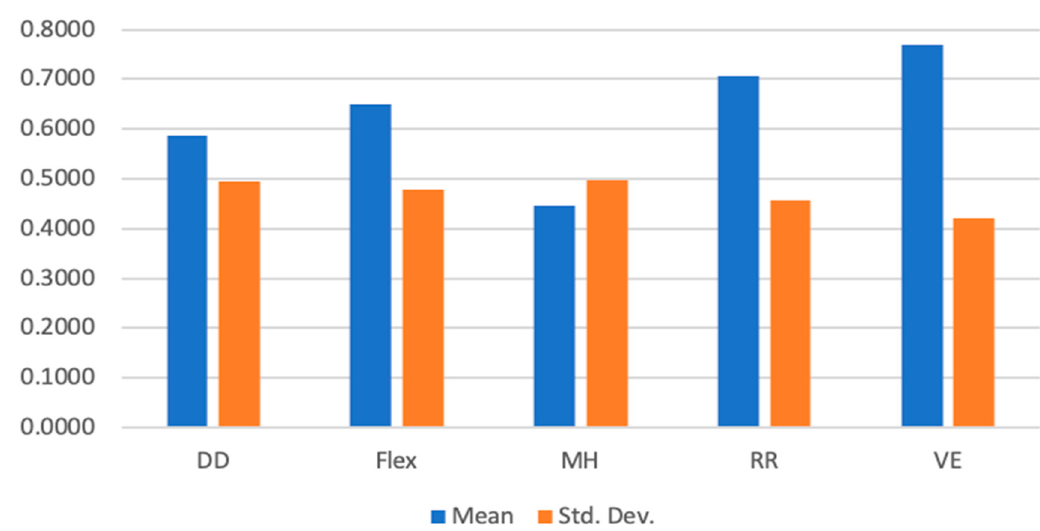
Figure 2. Survey response regarding DM model components.